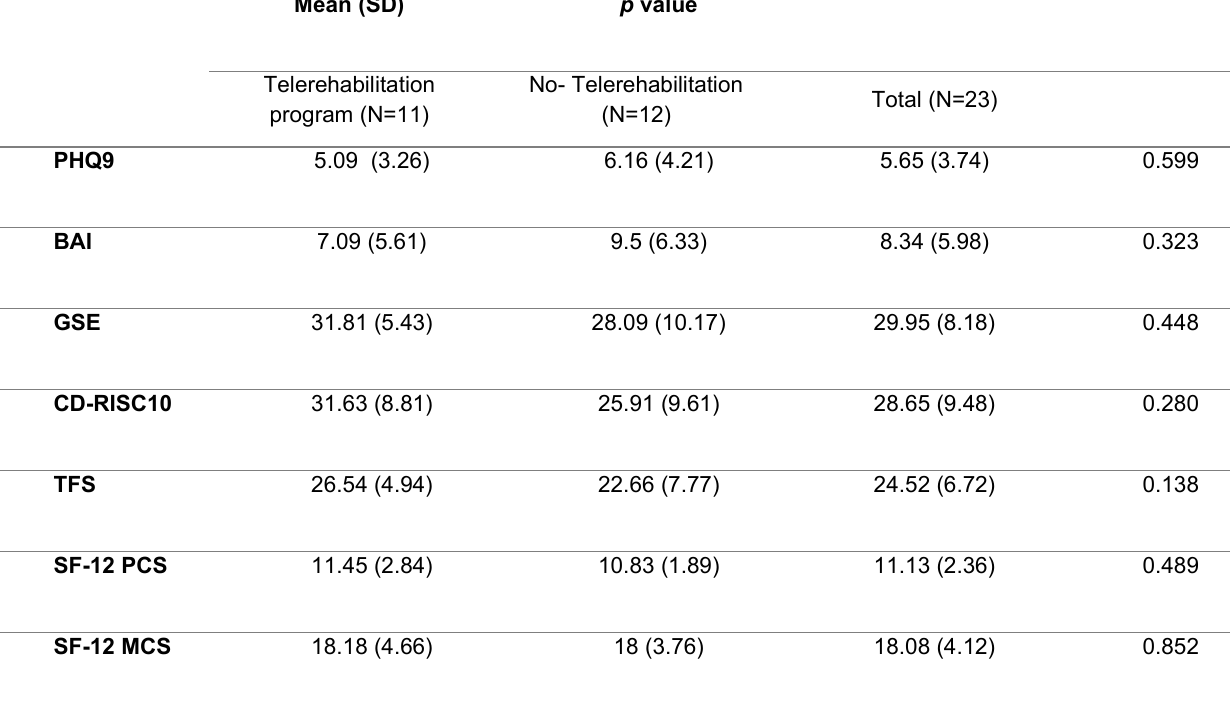
The Psychological and Physical Well-being at Readmission to